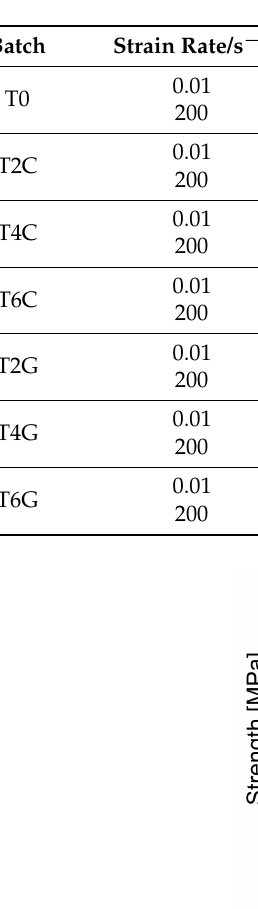
Table 4. Mechanical properties of the TRIP-steel matrix syntactic foams and the bulk matrix material under quasi-static and dynamic compression.